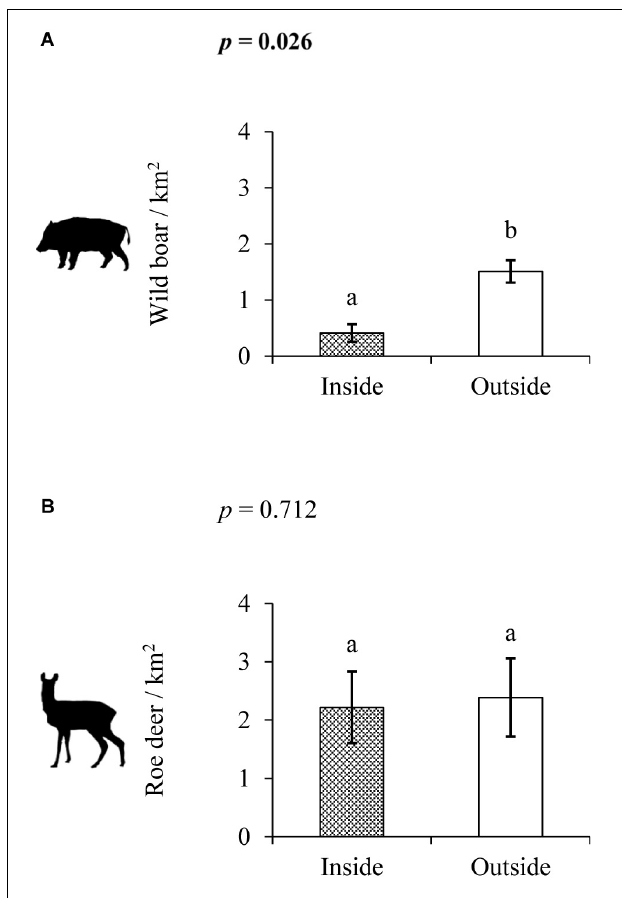
FIGURE 4 | Wild boar (A) and roe deer (B) density inside (shaded) and outside (non-shaded) forest cattle grazing enclosures. Mean and standard errors are shown. p values in bold and different lower case letters above columns indicate statistically significant differences ( p < 0.05) within each